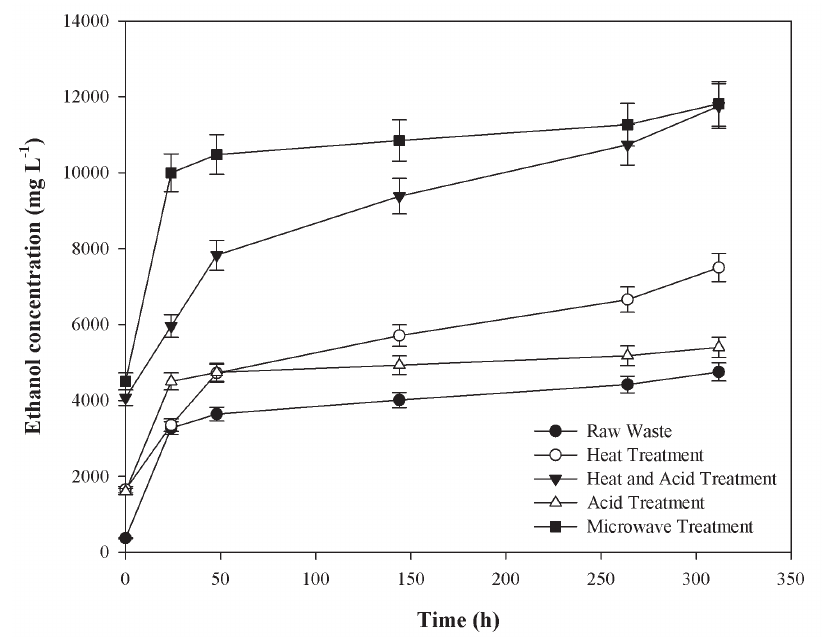
Fig. 2 – Ethanol production by yeast fermentation from FVWs